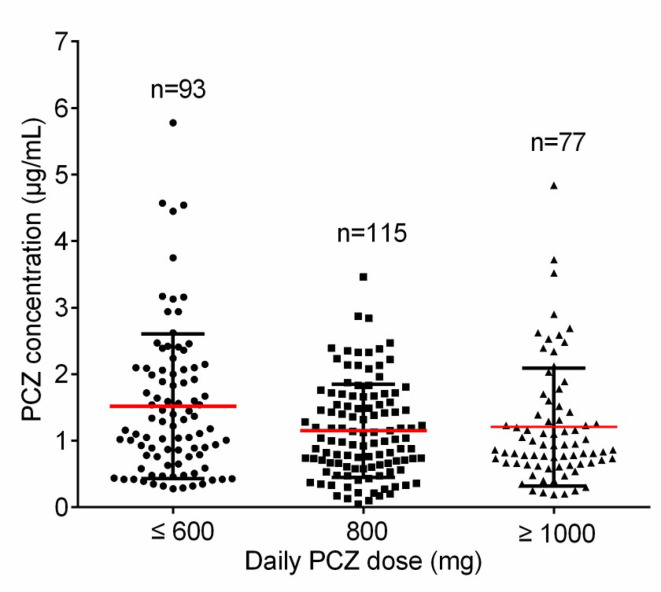
The distribution for PCZ trough concentrations. The horizontal red lines represent the mean value and the lower and upper black lines represent the SD value, respectively.